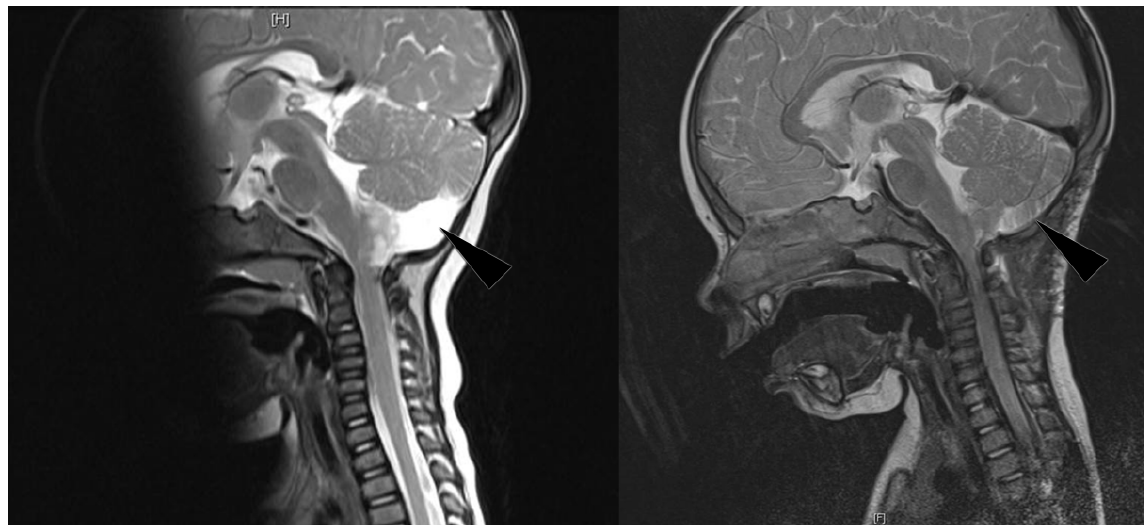
Figure 2: MRI before and after